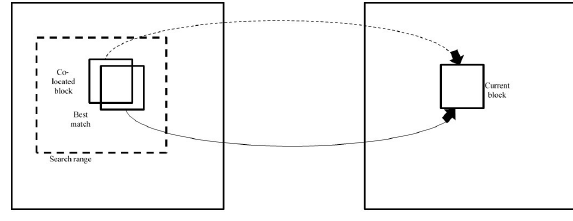
Fig. 1. Motion estimation to identify the best match in inter prediction in